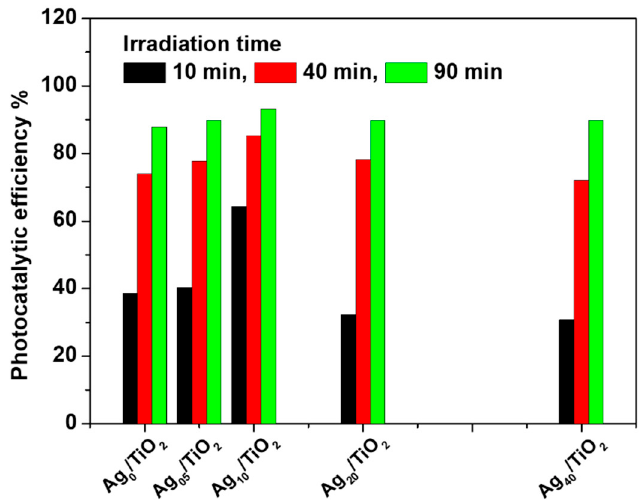
Figure 9. The photocatalytic efficiency toward MB degradation against the Ag x /TiO 2 samples after irradiation for 10, 40, and 90 min.